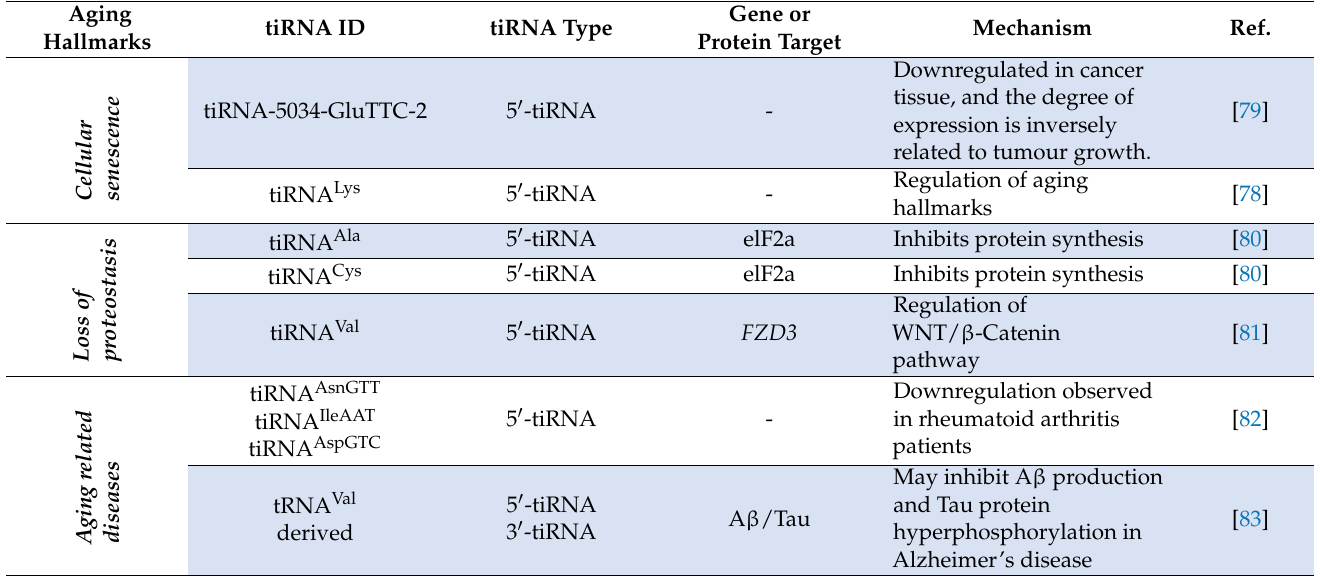
Table 3. tiRNAs linked to aging hallmarks and aging-related diseases.